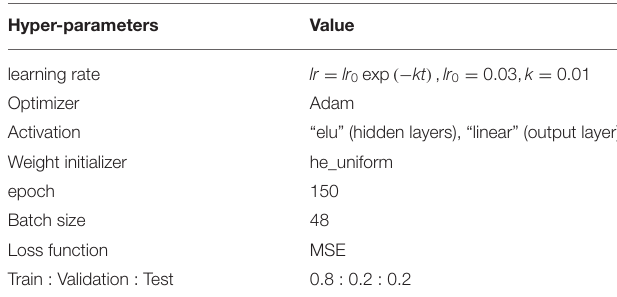
TABLE 3 | Hyper-parameters of ANN.